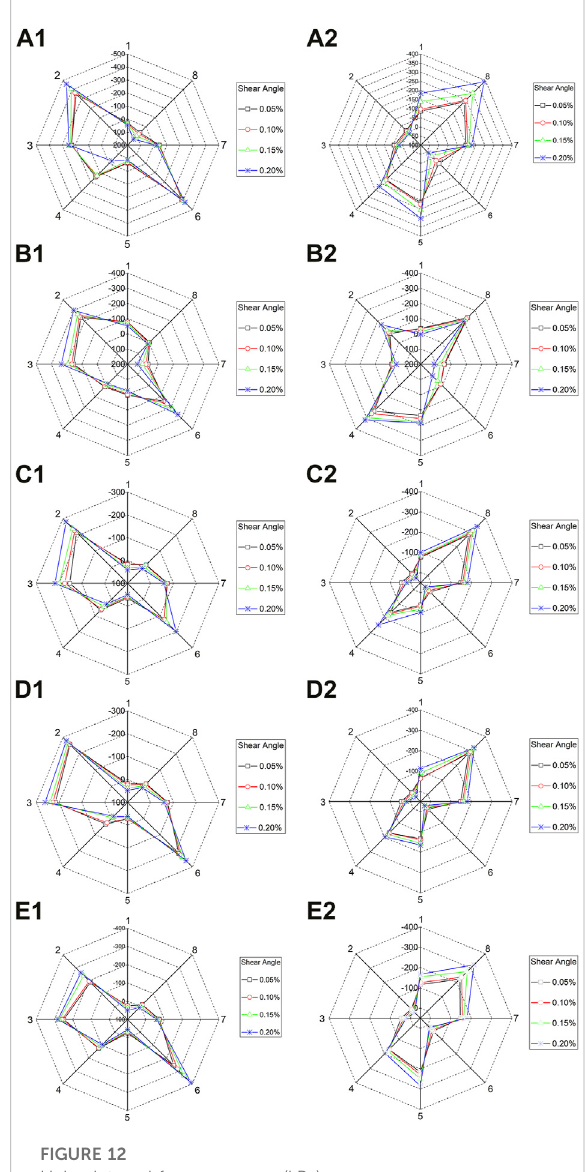
distribution diagram of lining A~E under different working conditions. Figure 12A1 represents the internal force response of shear deformation on the inside, and Figure 12A2 represents the stress response of shear deformation on the outside of lining A. The same rules apply to other linings